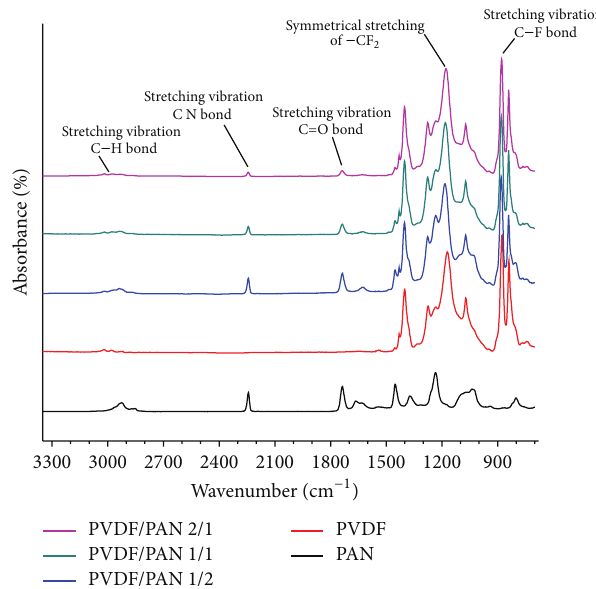
Figure 1: FTIR spectra of PVDF, PAN, and mixtures of PVDF/PAN nanofibres.